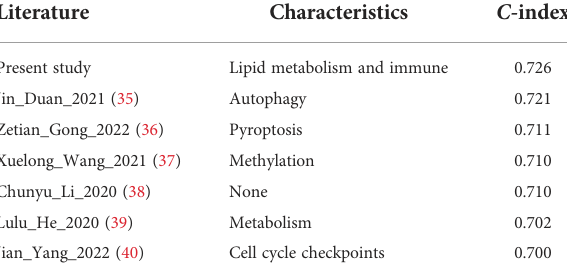
TABLE 3 Comparison with the C -indices of other previously reported nomogram models in the TCGA-LUAD cohort.